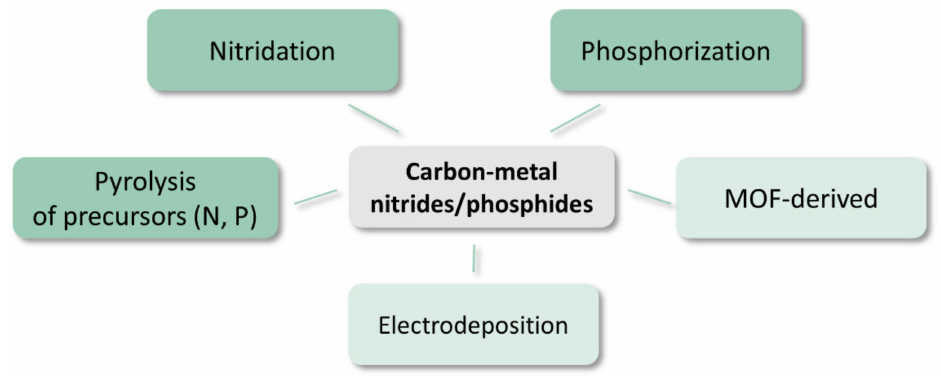
Figure 7. Graphical summary of synthesis methods of carbon–metal nitrides and